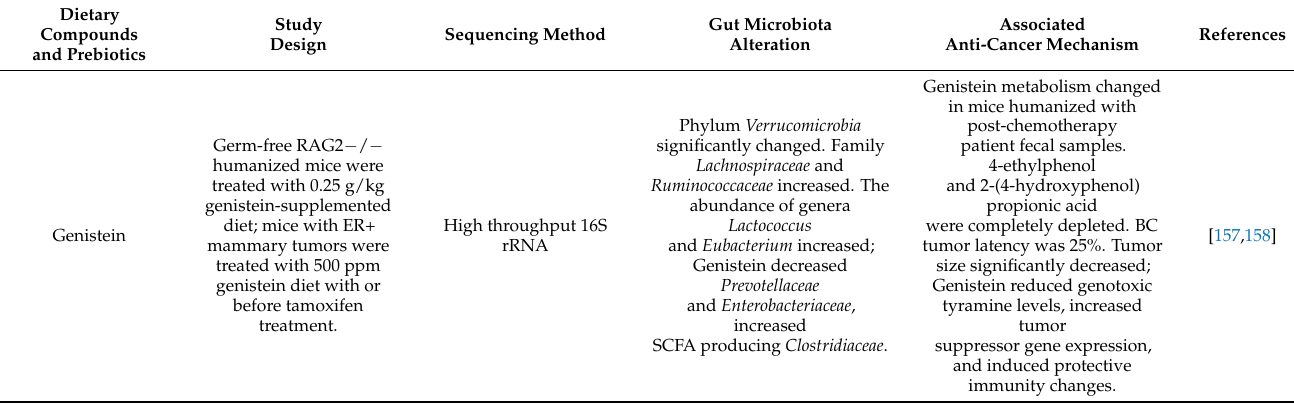
Table 2. Prebiotics and dietary compounds with prebiotic effects induce gut microbiota alterations which are associated with anti-cancer mechanisms in